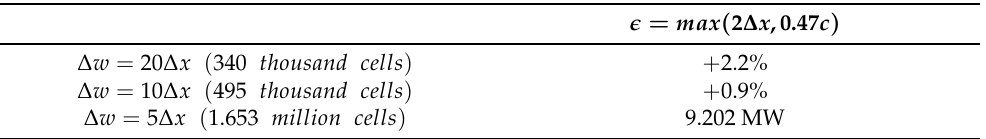
Table 3. Variation of power [MW] with increasing wake region characteristic length ∆ w [m]. Refer- ence power corresponds to minimum value ∆ w = 5 ∆ x .